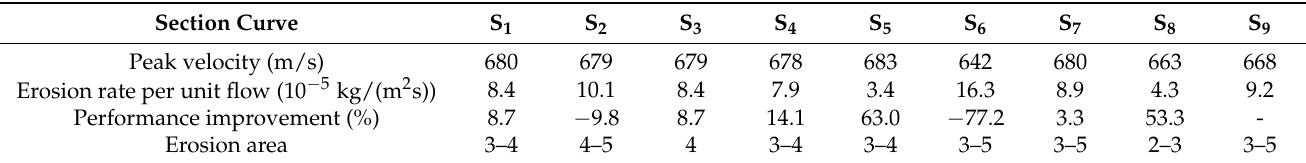
Table 6. Effect of section curves on nozzle performance.